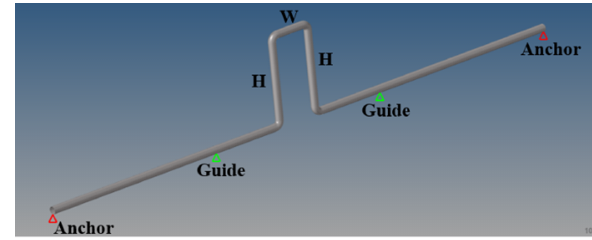
Figure 2: Applied boundary